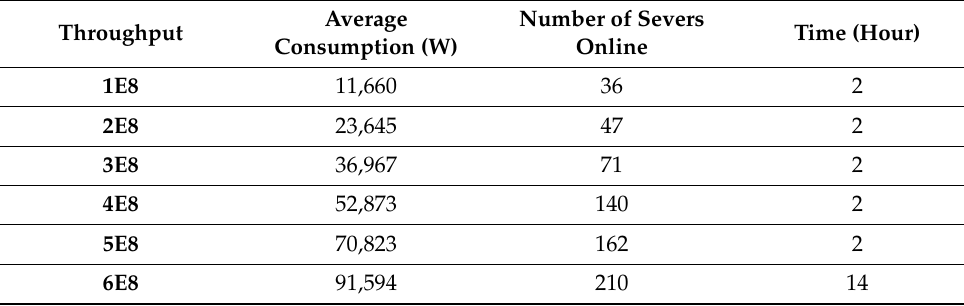
Table 6. Simulation results of data center #6.